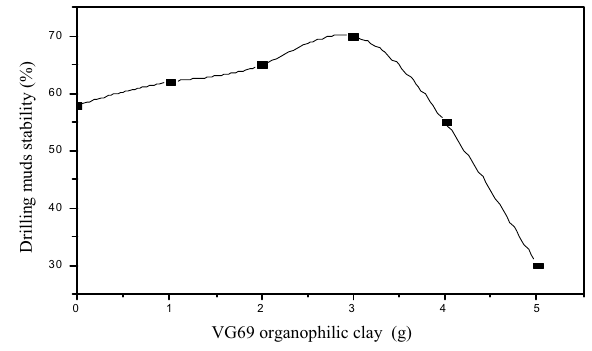
Fig. 4 Drilling muds stability as function of VG69 organophilic